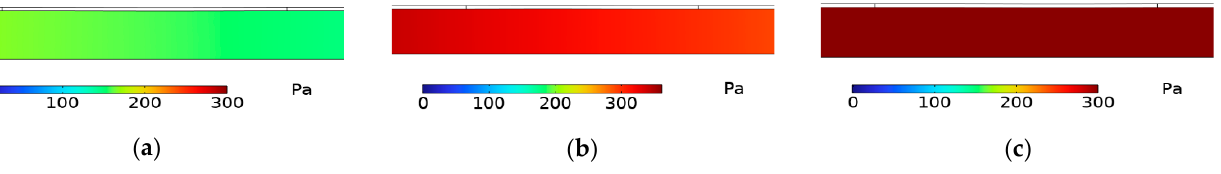
Figure 5. Simulation results of intravascular pressure under different blood viscosity at P = P e : ( a ) Simulation results of intravascular pressure when blood viscosity is η (cid:48) = 0.5 η . ( b ) Simulation results of intravascular pressure when blood viscosity is η (cid:48) = η . ( c ) Simulation results of intravascular pressure when blood viscosity is η (cid:48) = 1.5 η .